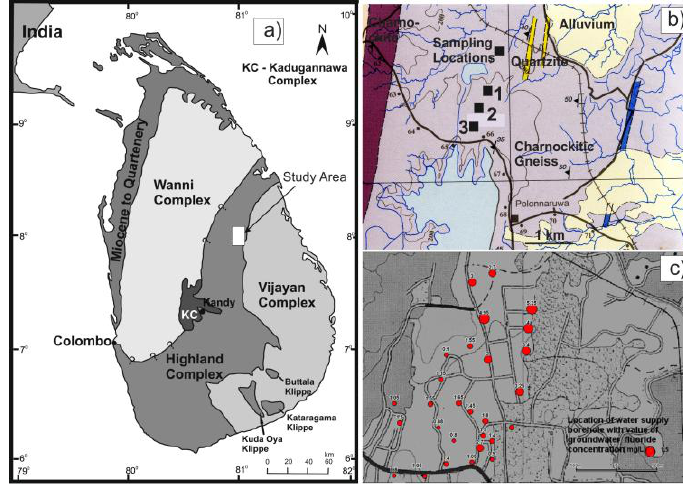
Figure 1 : (a) Litho-tectonic units of Sri Lanka (after Cooray, 1994) showing the study area. b) Sample locations showing the three sites. c) Fluoride distribution in groundwater of the study